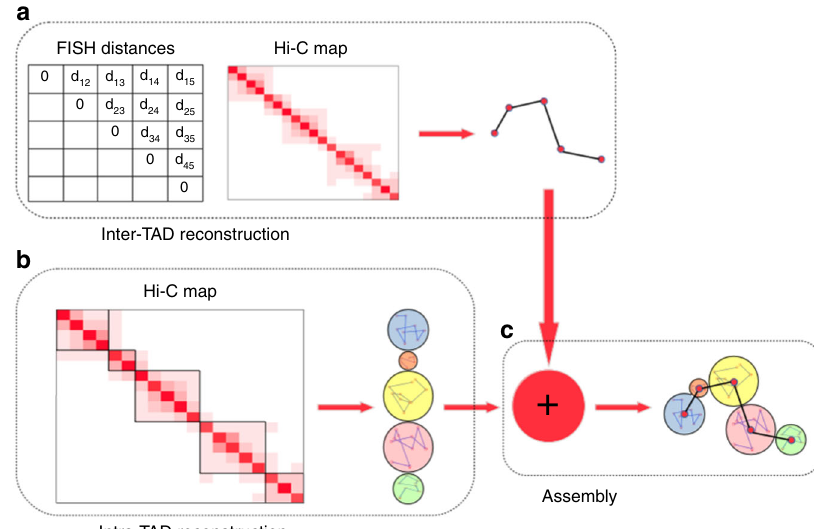
Fig. 1 The schematic overview of GEM-FISH, which applies a divide-and-conquer strategy to reconstruct the 3D organization of a chromosome by systematically integrating both Hi-C and FISH data. a The 3D chromosome model at TAD-level resolution is calculated by integrating Hi-C and FISH data as well as prior biophysical knowledge of a 3D polymer model. b The 3D conformations of individual TADs are determined using the intra-TAD geometric restraints derived from the input Hi-C map and prior biophysical knowledge of polymer models. c The fi nal complete 3D structure of the chromosome is obtained by assembling the modeling results from the previous two steps, i.e., placing the previously determined intra-TAD conformations into the TAD- level resolution model through translation, rotation, and re fl ection operations. More details can be found in the main text